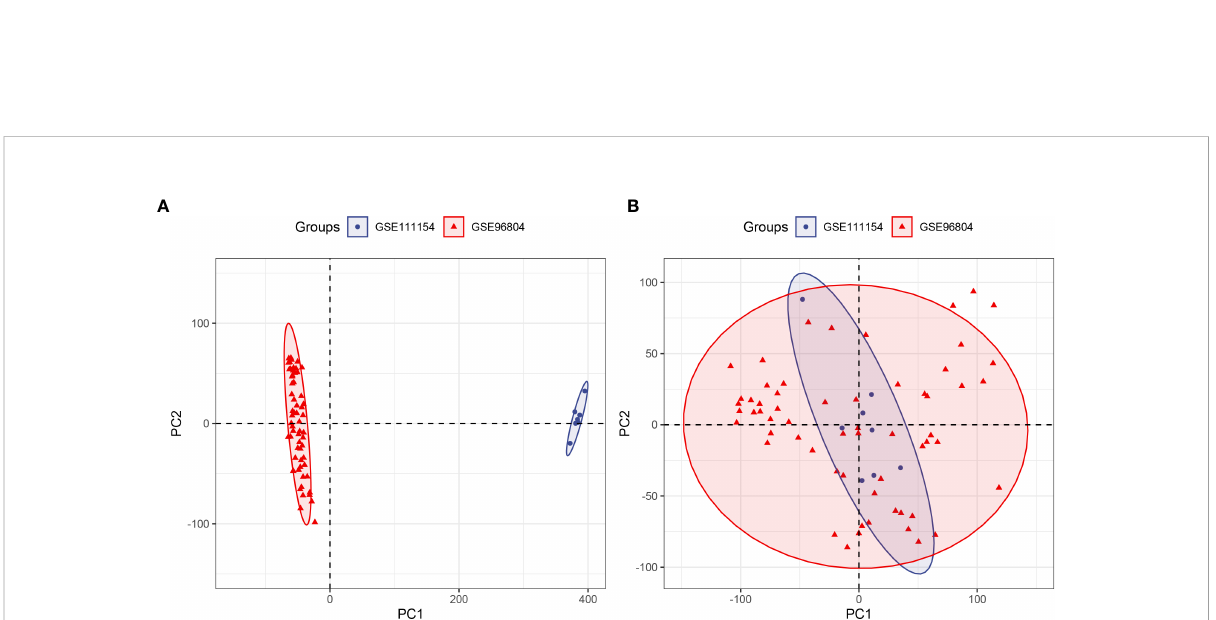
FIGURE 2 Principal component analysis (PCA) of two datasets (GSE96804 and GSE111154). The points of the scatter plot represent the samples without (A) and with (B) the removal of batch effects according to the fi rst two principal components of gene expression pro fi les.